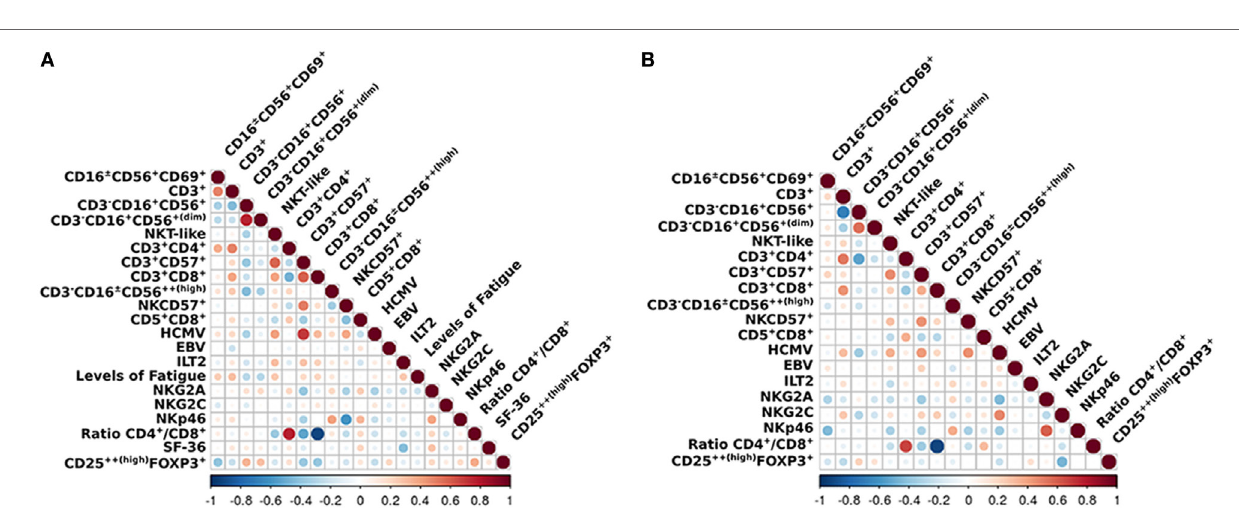
FigUre 5 | Overview of the correlations of the analized immunophenotypes. Differences between (a) myalgic encephalomyelitis/chronic fatigue syndrome patients and (b) healthy controls. Color marks positive (red) or negative (blue) correlation. The size of the circle indicates the scale of the correlation.